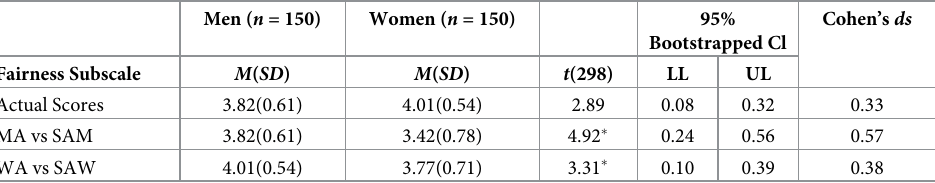
Table 3. Comparison of gender on actual and stereotype scores on fairness subscale (N = 300).